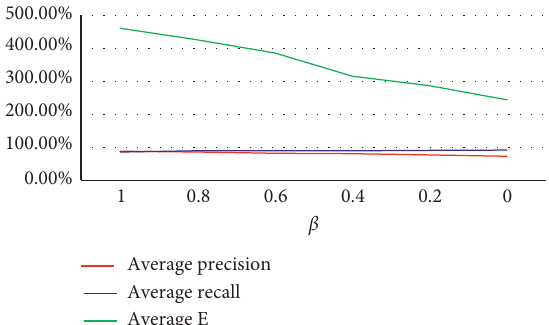
Figure 6: Compared results with varying β